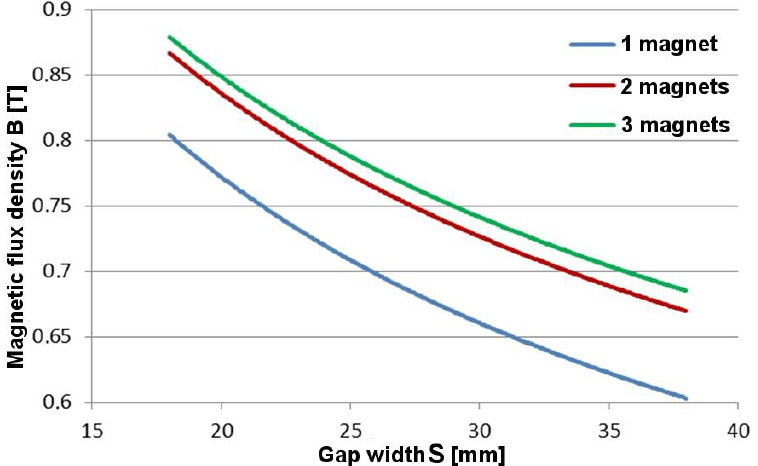
Figure 12. Impact on the magnetic flux density on the surface of separators depending on the machining gap width and number of magnets, obtained from simulation.